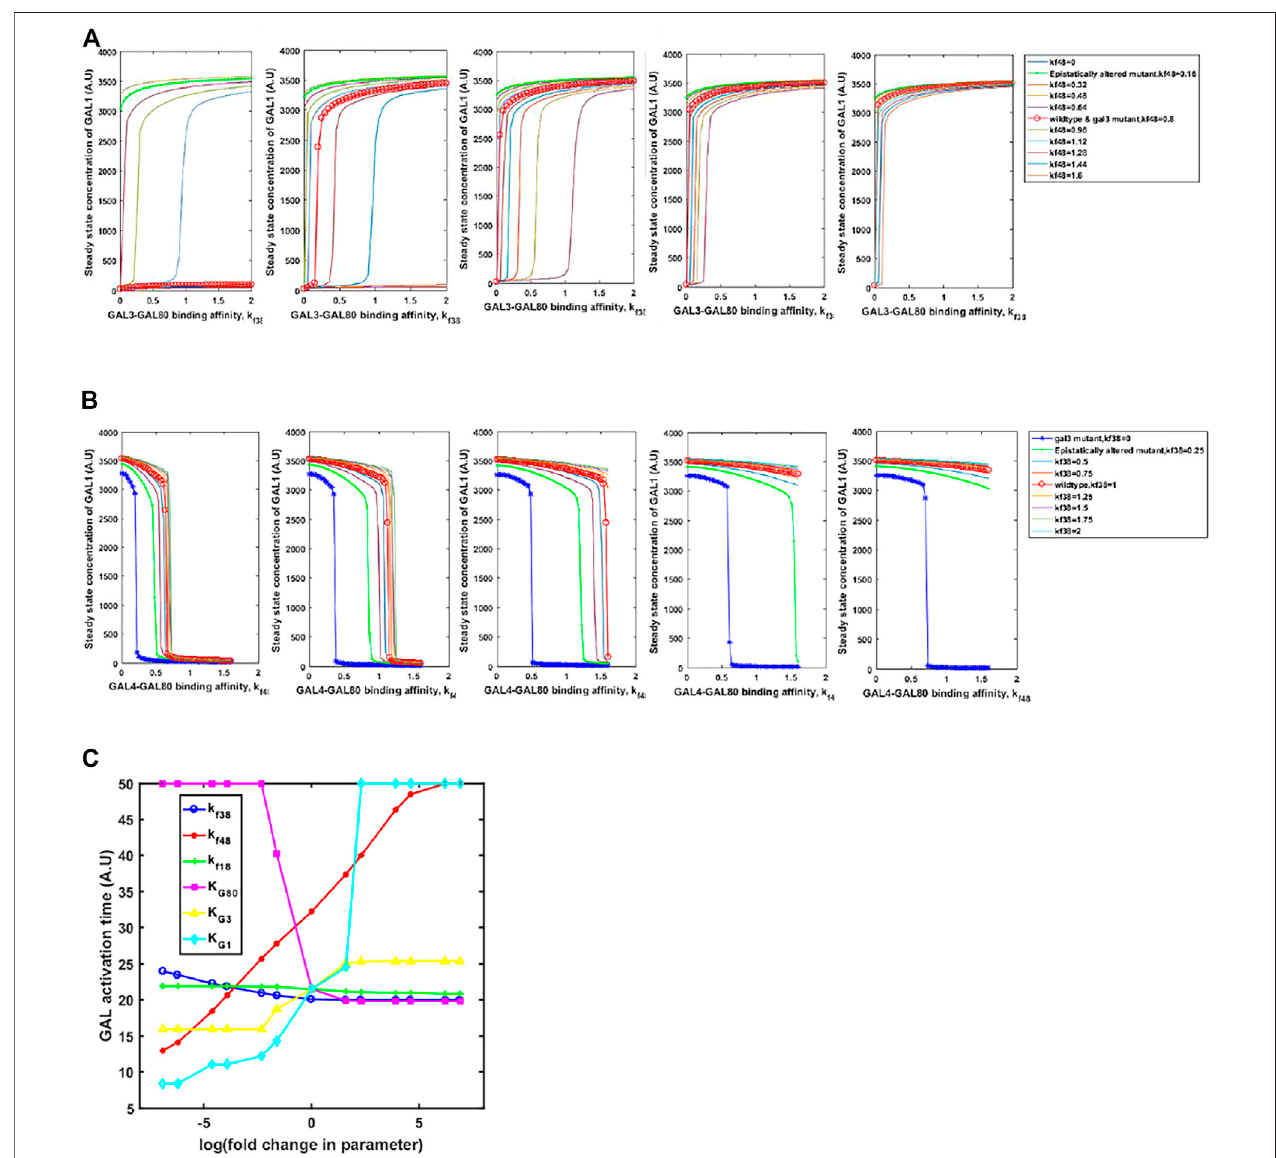
FIGURE7| SteadystateGAL1concentrationplottedagainstthebindingaf fi nitybetweenGAL3-GAL80fordifferentGAL4-GAL80.In (A) thechangeinGAL3-GAL80 interaction is represented on the x -axis. Different curves represent different strengths of GAL4-GAL80 interaction, as indicated in the legend. In (B) , the change in GAL4- GAL80interactionisrepresentedonthe x -axis.DifferentcurvesrepresentdifferentstrengthsoftheGAL3-GAL80interaction,asindicatedinthelegend.Inboth (A) and (B) , the fi ve panels represent a galactoseconcentrationof 5, 10,15,20,and 25 A.U. (from left toright). (C) Timetaken toreachmaximalGAL1p productionrate, ascells transition from glucose to